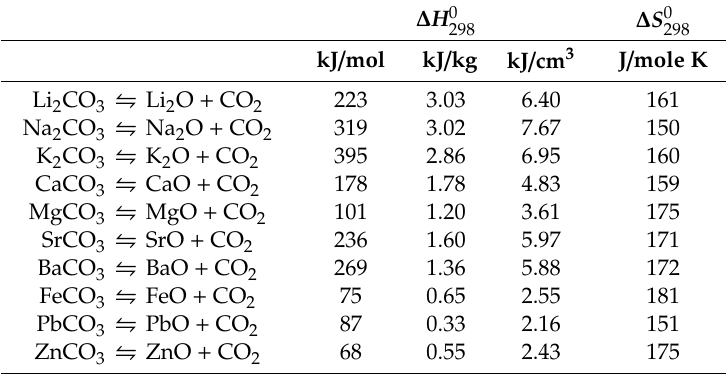
Table 2. Heat / entropy of reaction for the most relevant carbonate-oxides, adapted from Table 2. Heat/entropy of reaction for the most relevant carbonate-oxides, adapted from [30]. 𝜟𝑯 𝟐𝟗𝟖𝟎 𝜟𝑺 𝟐𝟗𝟖𝟎